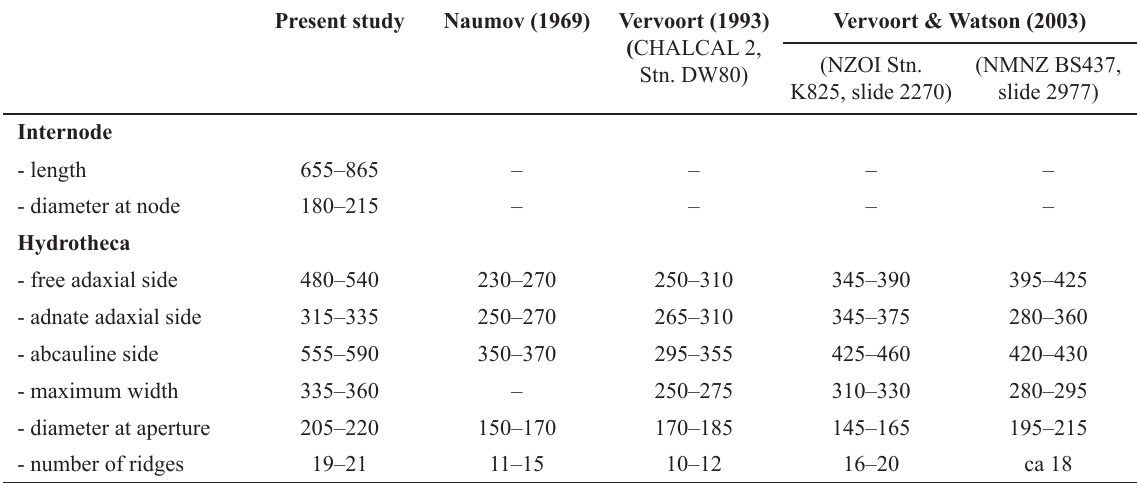
Table 4. Measurements (in µm) of Sertularella sinensis Jäderholm, 1896 from various sources. Present